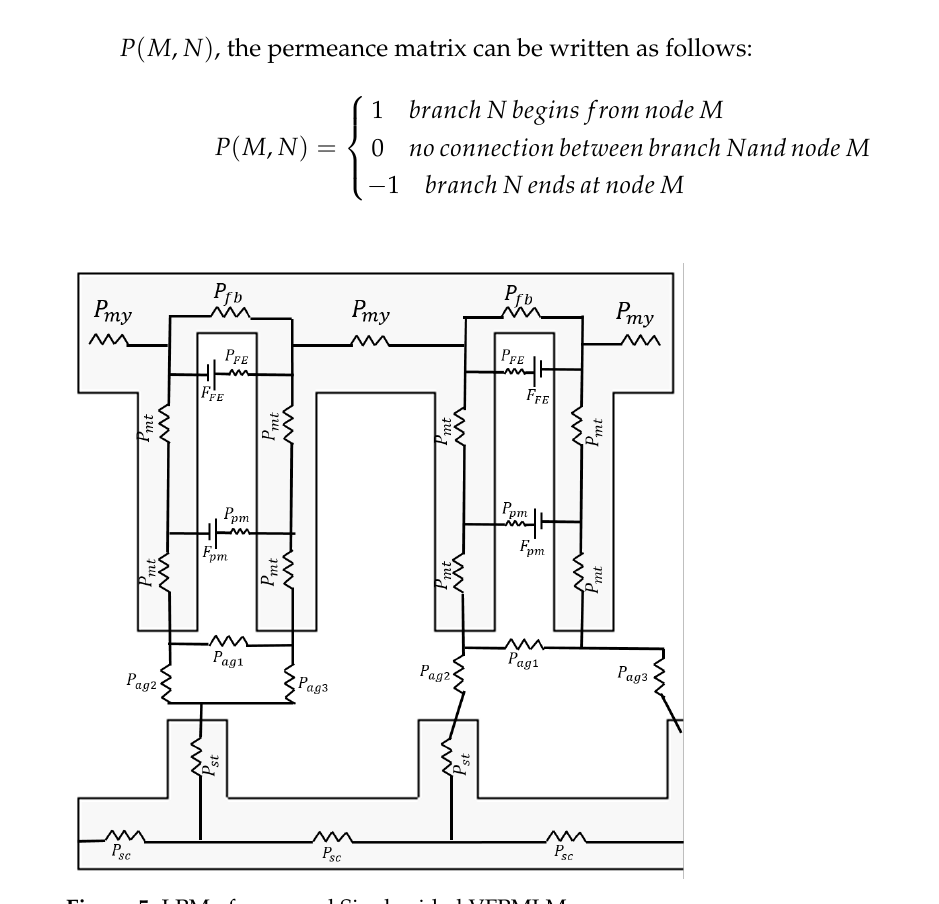
Figure 5. LPM of proposed Single-sided